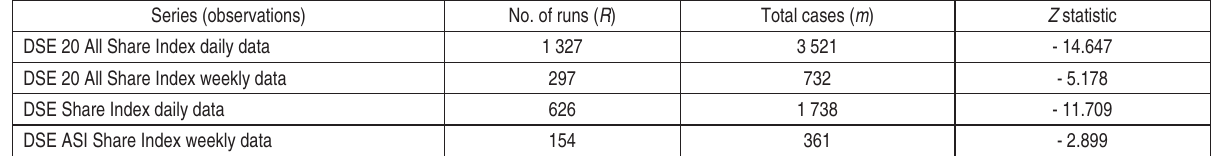
Table 4. Results of the runs test